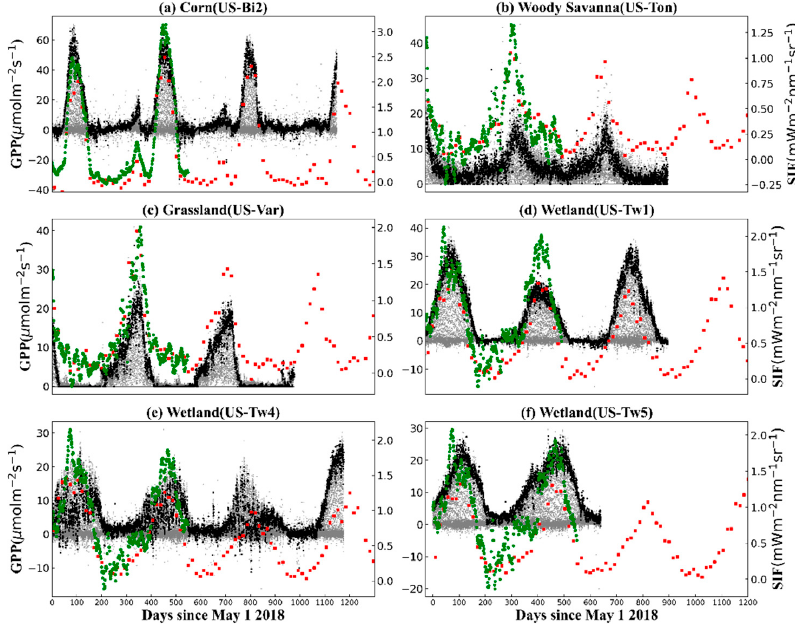
Figure 12. Time series of CASIF, TSIF, and GPP at six eddy covariance sites from AmeriFlux. Black points are the GPP measurements between 12:00 and 14:00 corresponding to the overpass time of TROPOMI; gray points represent all GPP measurements from six eddy covariance sites; green points represent CASIF; red points represent TSIF. The left axis is for GPP, the right axis is for SIF. The x -axis shows the number of days since 1 May 2018 ( a – f